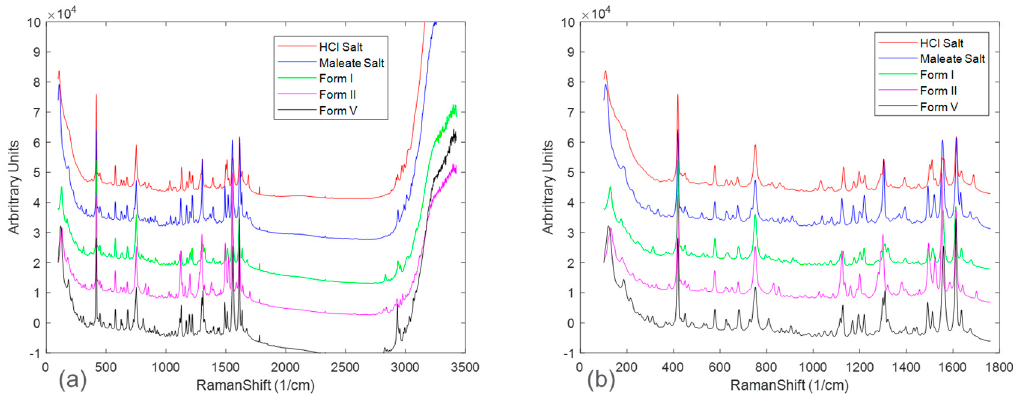
Figure 2. Full ( a ) and truncated ( b ) pure component Raman spectra (baseline offset for ease of visual comparison) of the two salts (HCl and Maleate) and the three observed freebase polymorphs. Figure 3 zooms in on Raman spectral peaks from four solid concentrations at the end of the disproportionation for both HCl and maleate salts. For the HCl salt, the spectral changes associated with solid concentrations were observed to be peak intensity offsets.